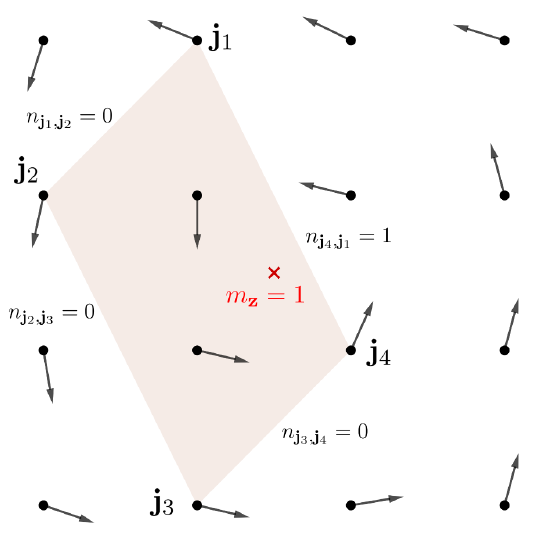
Figure 1 . A topological configuration, namely a vortex with charge m z = 1 , and a corresponding choice of the Villain link variables which encircle a parallelogram in such a way to satisfy the constraint (2.18). In agreement with the symmetry (2.4) the choice of the n from zero is